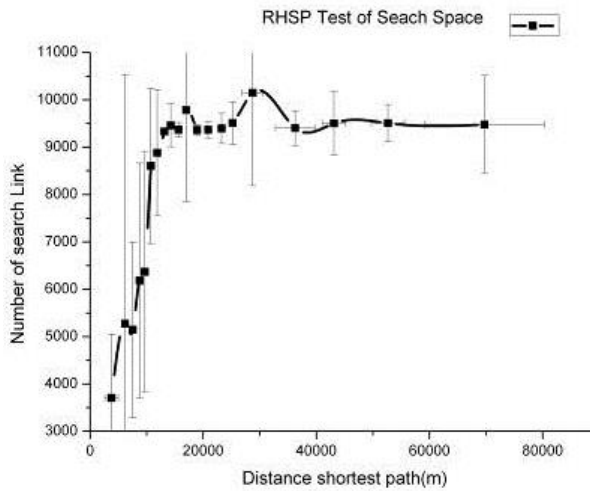
Figure 8. Number of the searched links of the hierarchical shortest-path algorithm (RHSP).